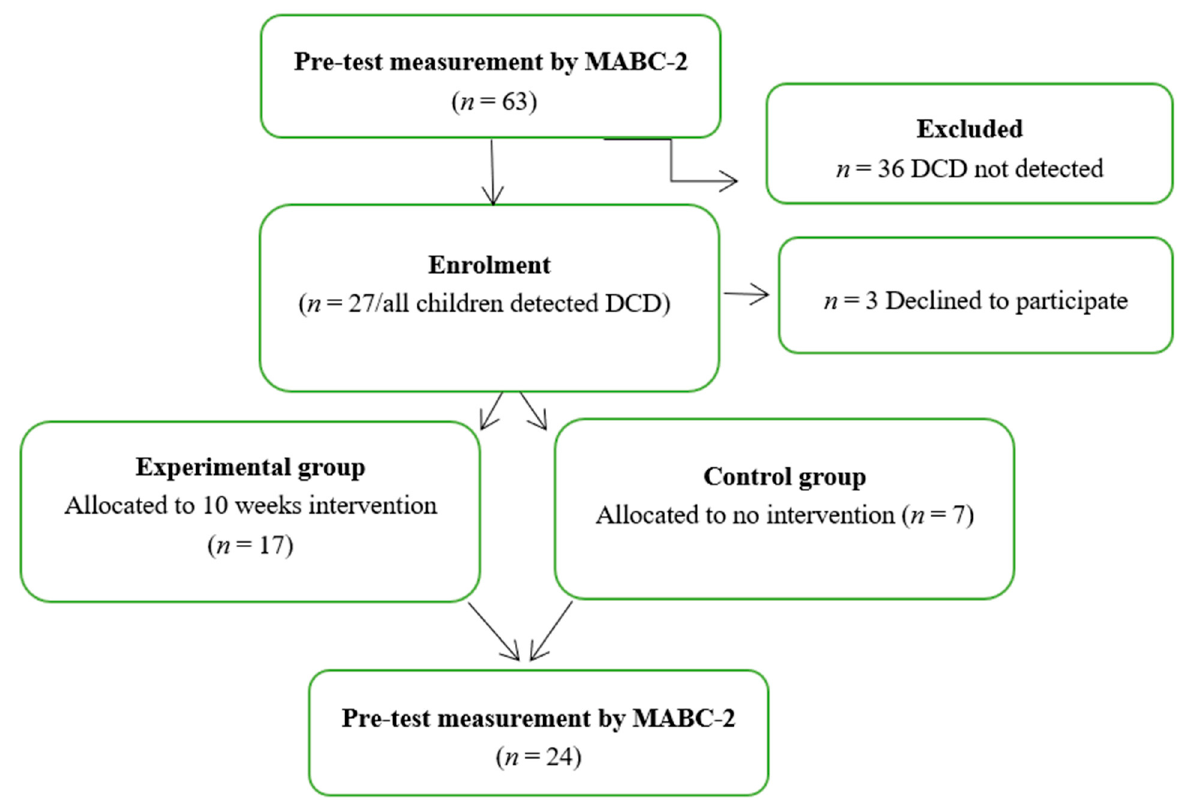
Figure 1. CONSORT flow